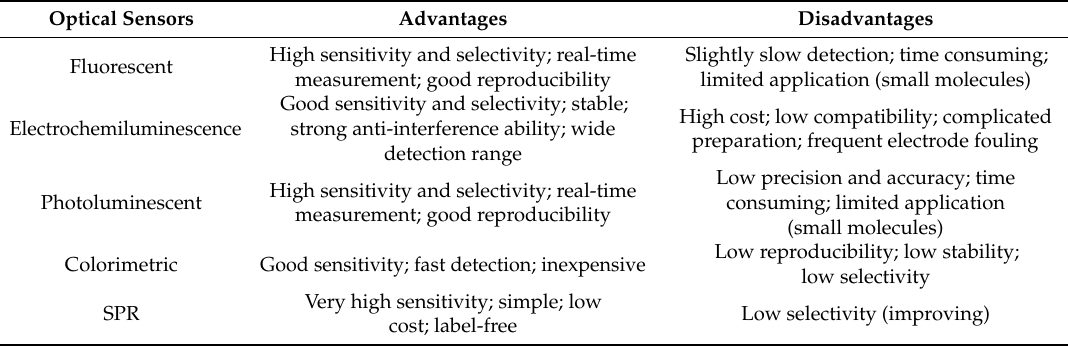
Table 1. The advantages and disadvantages of optical sensors. SPR: surface plasmon